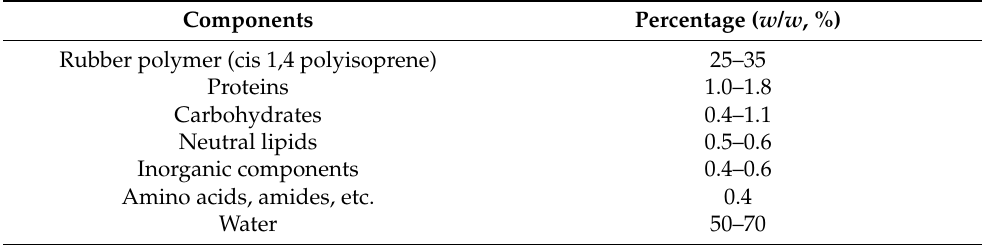
Table 1. Component in colloidal dispersion of NR latex